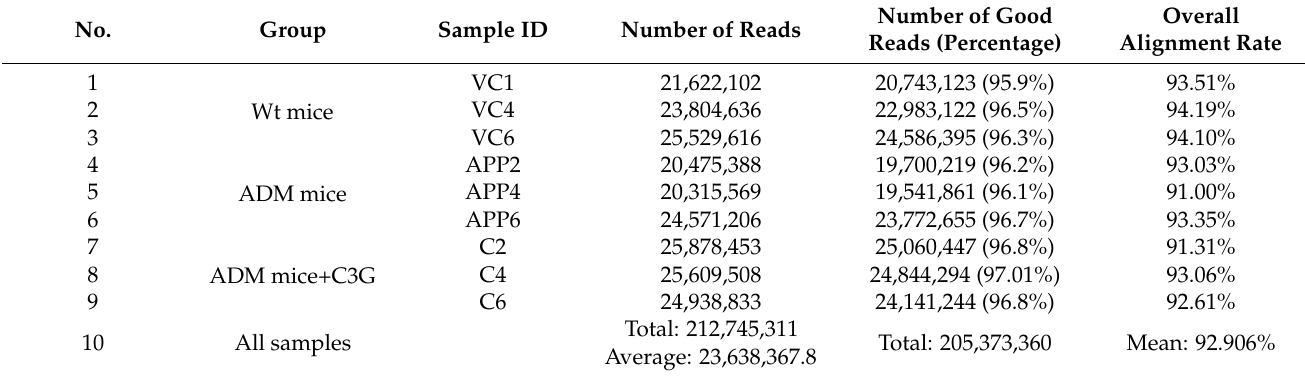
Table 1. Preprocessing and alignment results of all nine